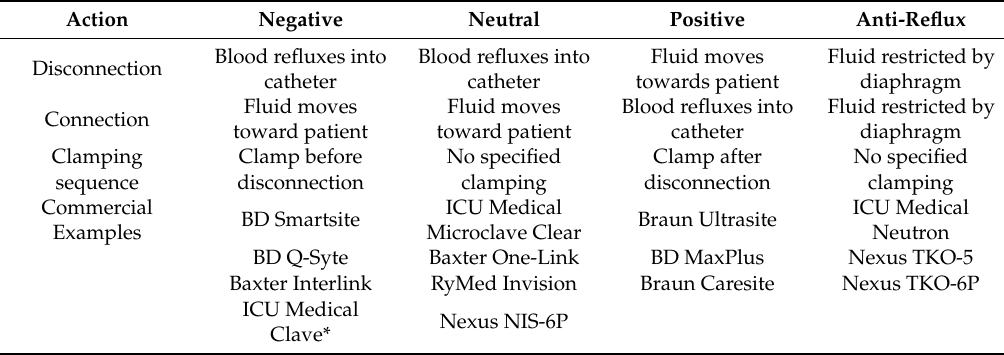
Table 1. Classification of needle free connector hubs in terms of fluid